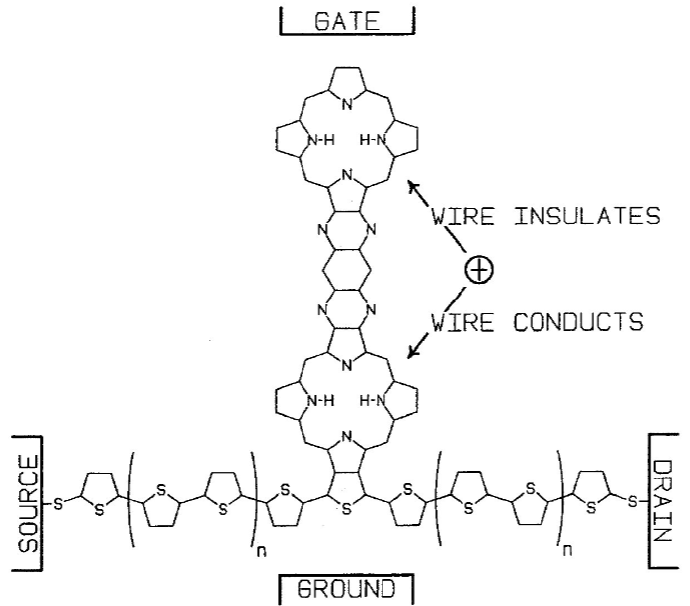
Figure 13. An oligoporphyrin-containing molecular switch, after [32], with permission from IOP Publishing Co. “+” indicates location of electron hole on oligoporphyrin side